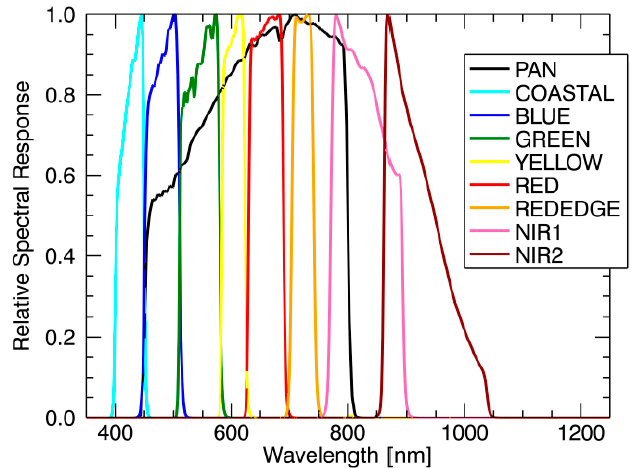
Figure 4. WorldView-3 Relative Spectral Radiance Response (nm) for the VNIR bands [38].